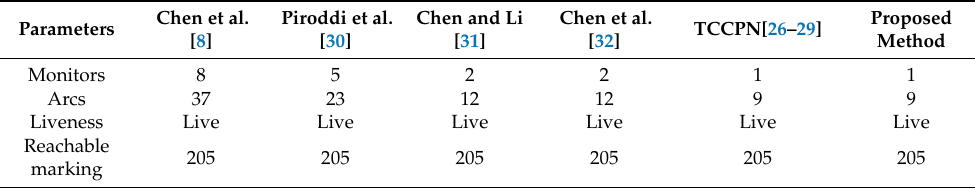
Table 2. Comparison with the existing policies: number of monitors, number of arcs, liveness, and reachable